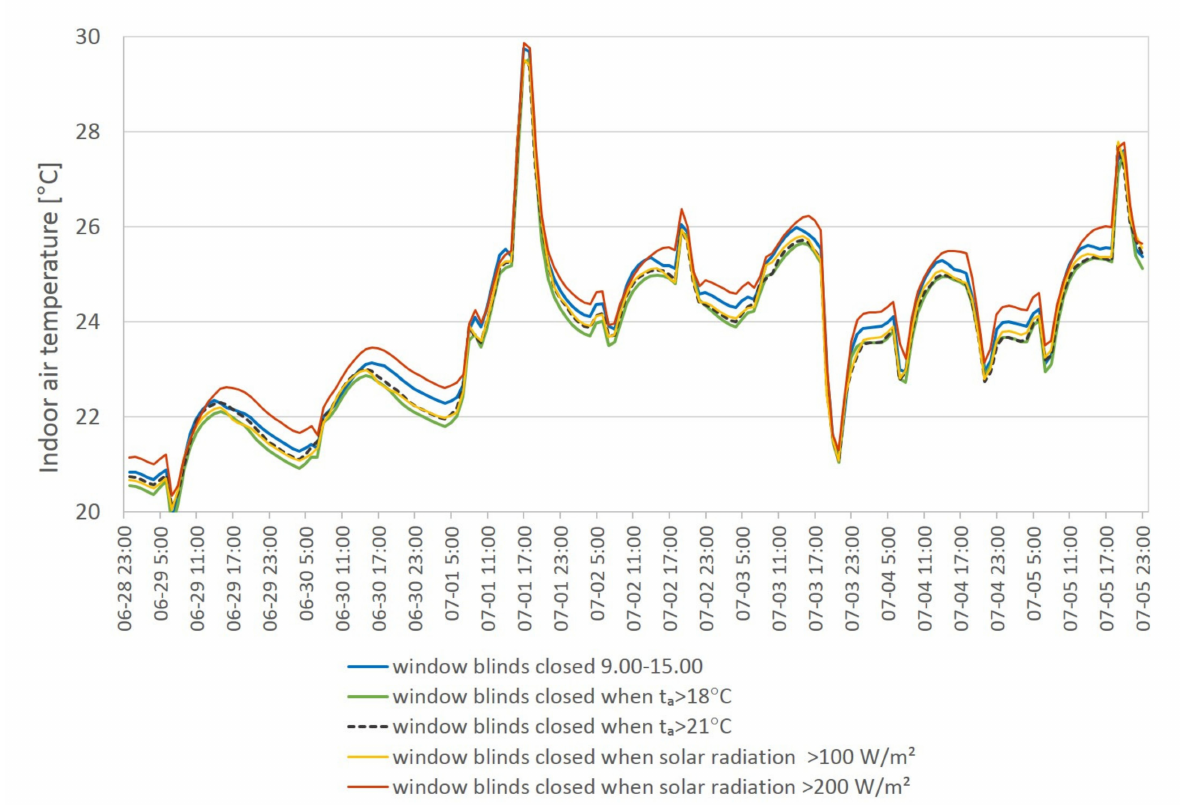
Figure 14. Distribution of indoor air temperature for the selected week. The variant, in which closing the blinds was conditioned by the maximum value of solar radiation intensity equal to 200 W/m 2 , is the least favorable for the analyzed summer period and generates the highest temperatures in the hall (orange graph Figure 14). Two out of the five applied variants practically overlay in weekly distribution. The yellow graph (irradiance > 100 W/m 2 ) and the gray dashed graph (t a > 21 ◦ C) do not show significant mutual differences in the course of the temperature in the hall but are more favorable in relation to the initial variant. The blue graph, reflecting the actually applied shading schedule from 9 a.m. to 3 p.m., is not, as can be seen in Figure 13, the best solution for limiting direct radiation. The lowest temperatures are observed in variant 2 (green graph) when the blinds are closed at ta >18 ◦ C. It is worth noting again, however, that